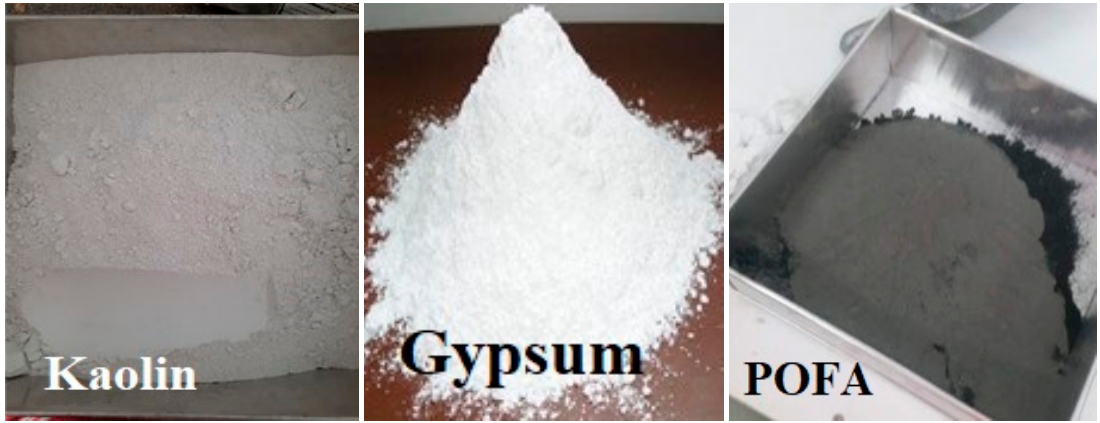
Figure 2. Used POFA, kaolin, gypsum in experimental laboratory work.